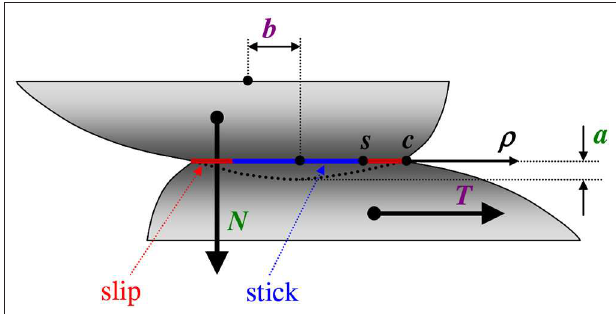
FIGURE 1 | Geometry of the Hertz-Mindlin problem and important parameters.